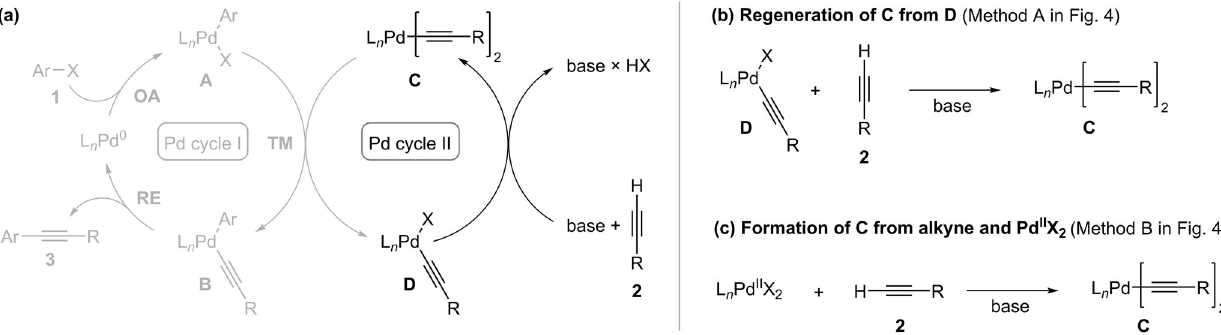
Fig. 2 Proposed formation of organometallic nucleophile. Breaking a highlighted ‘ Pd catalytic cycle II ’ into reaction for b regeneration of palladium bisacetylides C from palladium monoacetylides D and c initial formation of palladium bisacetylides C from L n Pd II X 2